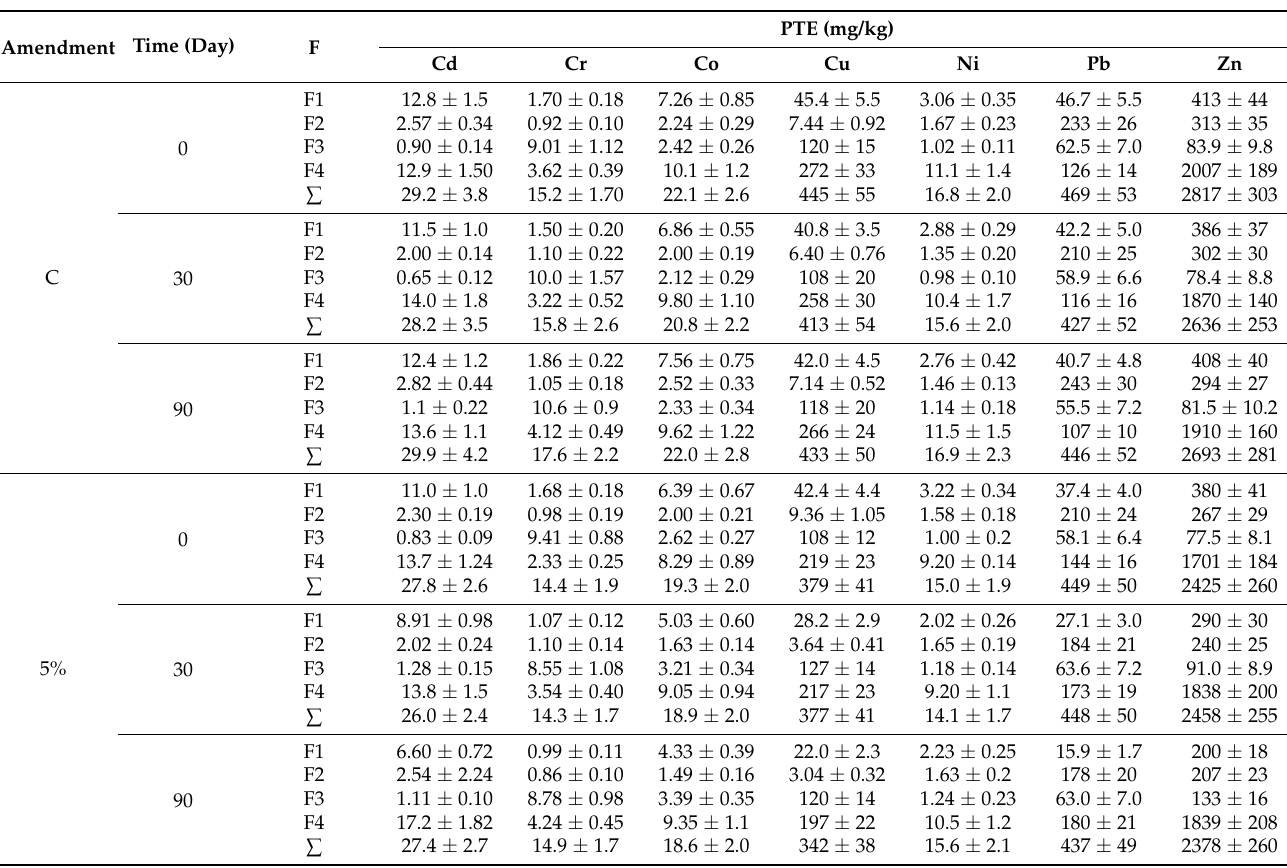
Table 3. Potentially toxic element (PTE) concentrations in exchangeable and weak acid soluble fraction (F1), reducible fraction (F2), oxidizable fraction (F3), residual fraction (F4), and sum of F1–F4 ( ∑ ) in the control soil (C) and soil amended with 5% (TZS5) and 10% (TZS10) zeolite at 0, 30, and 90 days after amendment. Amendment Time